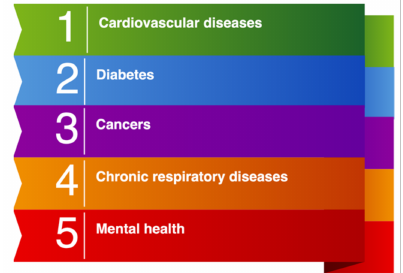
Figure 1. Non-communicable diseases